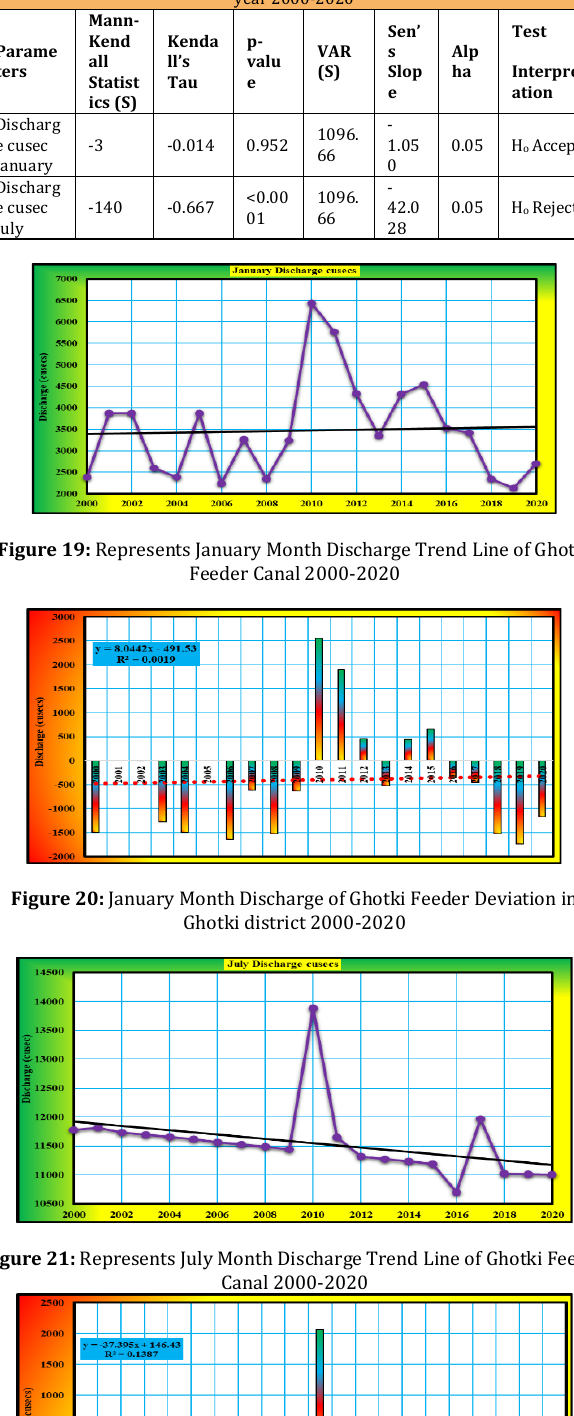
Table 5: Summary statistics of January and July Discharge of Ghotki feeder canal from 2000-2020 Obs. with Observat Variable ions